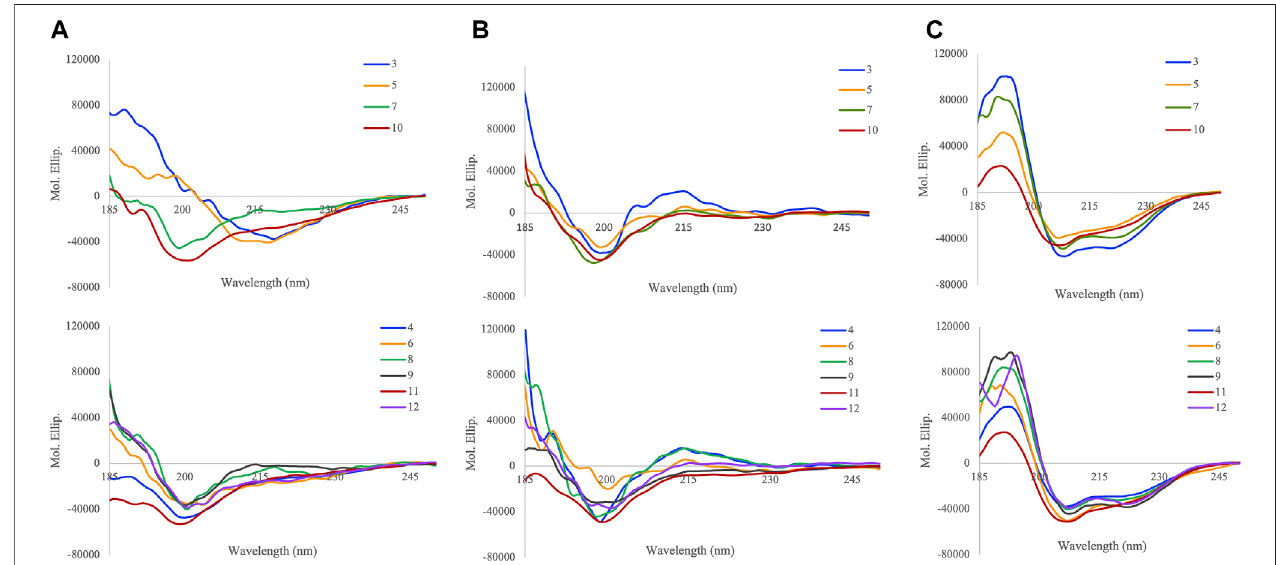
FIGURE1| CirculardichroismspectraofAPP(glyco)peptides 3 – 12 in (A) water (B) 10 mMsodiumphosphatebuffer,pH7.4,and (C) TFE/water=1:1(v/v)at25 ° C.